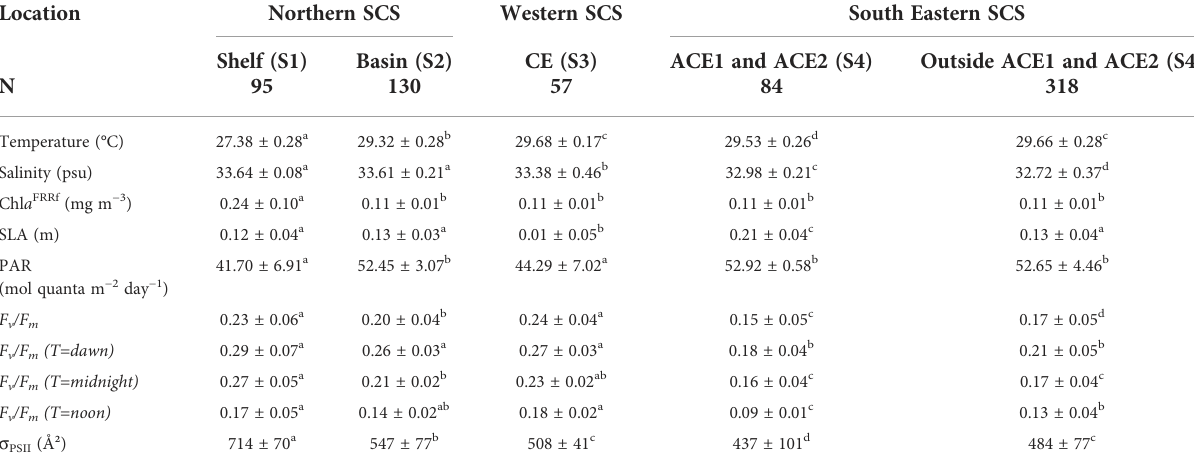
TABLE 1 Mean ± SD of surface environment conditions and FRRf-derived parameters performance in the SCS along the